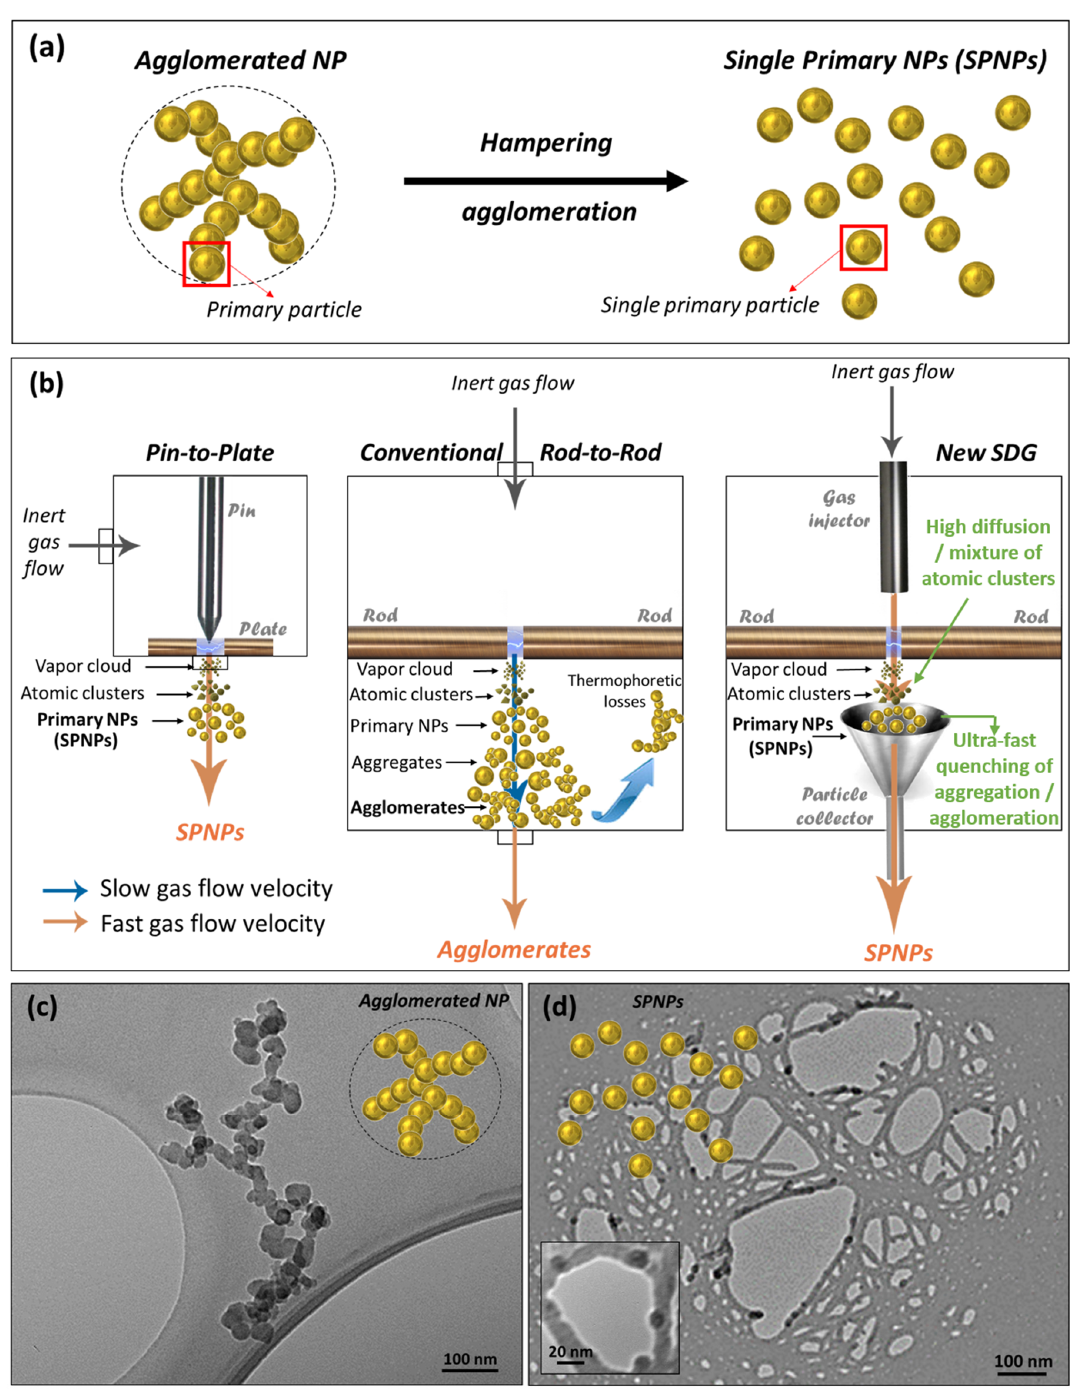
Figure 1. ( a ) Single primary NPs production by hampering agglomeration of primary particles. ( b ) Effect of different SDG geometries on the gas flow velocity and NP transport. ( c , d ) TEM images of: ( c ) agglomerated Ag NPs produced with a conventional rod-to-rod SDG, and ( d ) non-agglomerated Ag SPNPs manufactured with the proposed rod-to-rod SDG.